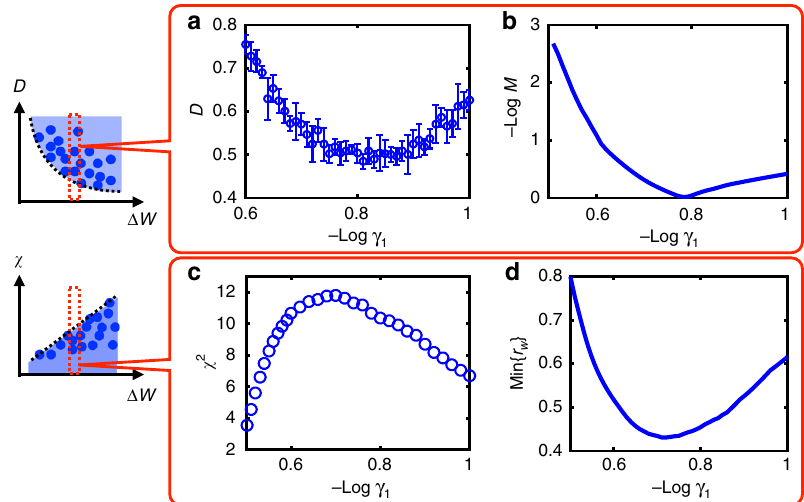
Fig. 5 Testing the design principles in the Brusselator model. We vary γ 1 and γ 2 together with a fi xed energy budget ( Δ W = 200). a , b The minimum phase 0 : 8, where the forward-backward ratio is matched for the two antiparallel pathways, i.e., M ≈ 1. c , d The phase sensitivity diffusion D occurs at (cid:2) log γ 1 (cid:10) reaches its maximum at (cid:2) log γ 0 : 7, where r w , the ratio of the net fl ux for the phase-retreating pathway over that of the phase-advancing pathway 1 (cid:10)